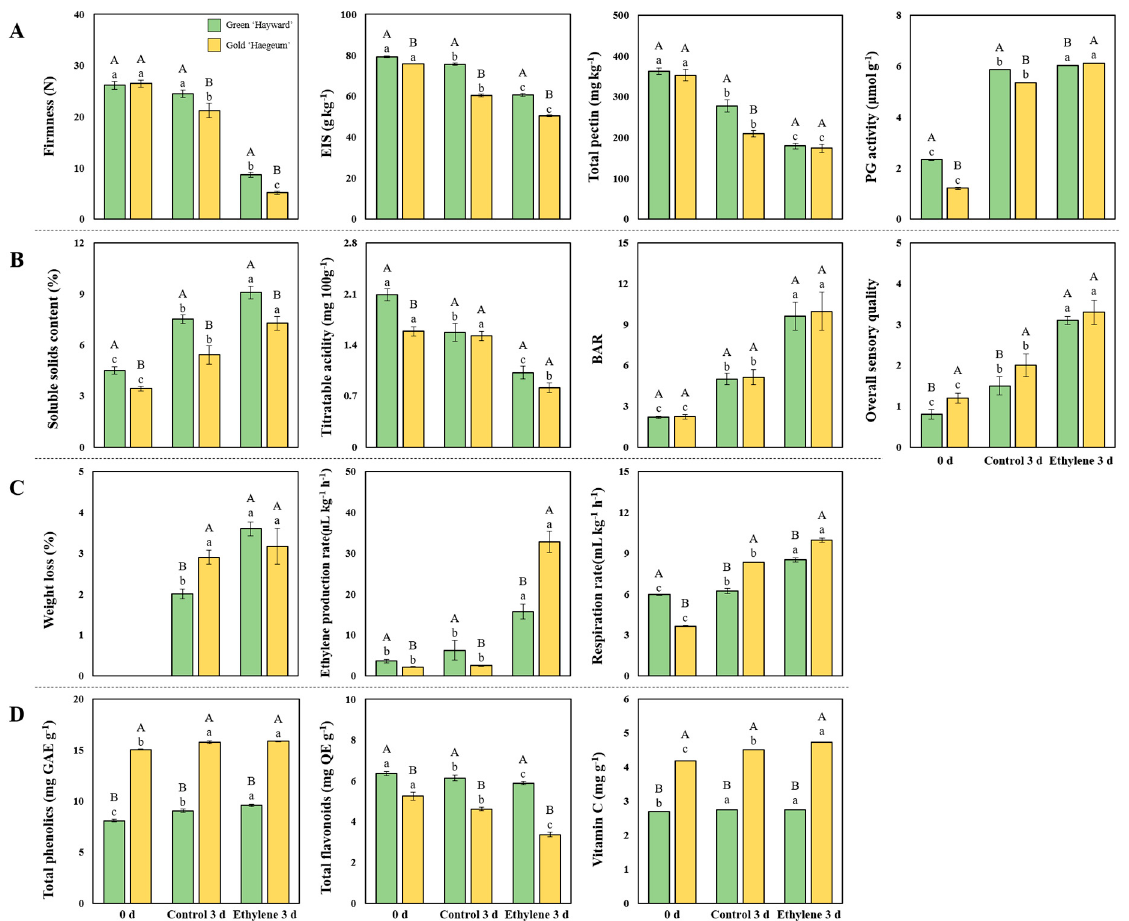
Figure 6. Firmness, EIS, total pectin and PG activity ( A ); soluble solids content (SSC), titratable acidity (TA), Brix/acid ratio (BAR) and overall sensory quality ( B ); weight loss, ethylene production and respiration rates ( C ); total phenolics, total flavonoids and vitamin C ( D ) of green ‘Hayward’ and gold ‘Haegeum’ kiwifruit on day 0 and third day of ripening at 25 ◦ C with ethylene treatment or without treatment (control). Data are presented as a mean ± standard errors in 10 replicates for firmness, SSC, TA, BAR and overall sensory quality; and in 5 replicates for the other parameters. The bars with different upper-case letters indicate a significant difference ( p < 0.05) between cultivars, the bars with different lower-case letters indicate a significant difference ( p < 0.05) between